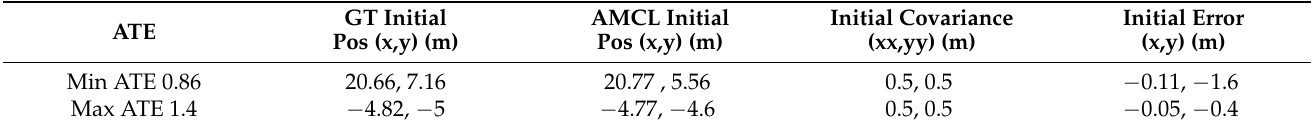
Figure 15. ( a ) AMCL simulation test with the highest ATE. AMCL (blue), ground truth (green), take-off position (blue circle), error (red). ( b ) AMCL errors. Table 5. Initial positions for lowest and highest ATE trajectories in truck inspections.